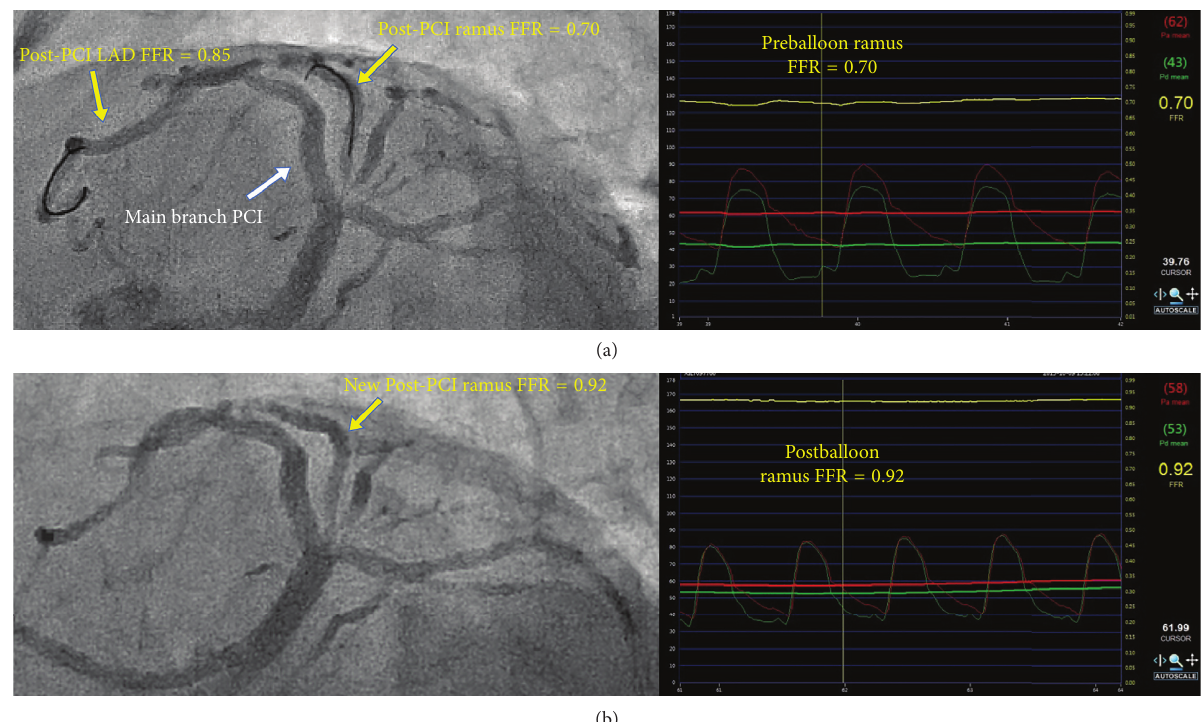
Figure 4: Use of post-PCI FFR for side branch assessment and optimization. (a) Suboptimal post-PCI FFR in the ramus (side branch) following bifurcation PCI, warranting further intervention. The pressure curve from this FFR measurement can be seen on the right. (b) Following kissing balloon dilation, post-PCI FFR in the ramus is